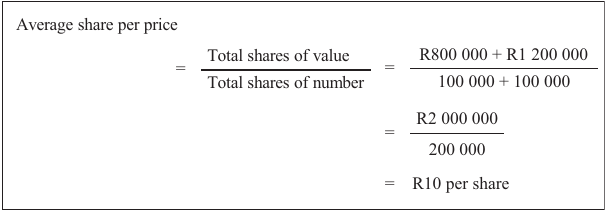
FIGURE 25: Method 1 formula – average price per share.